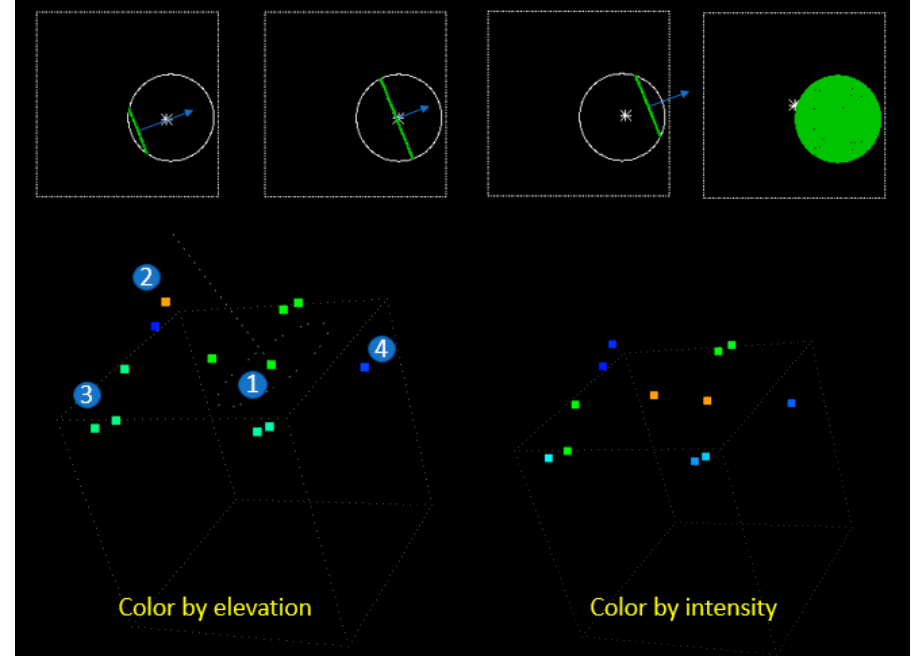
Figure 6. A cube target interacts with an incoming laser pulse at different locations. The 3D point cloud on the right side is colored by the intensity, which represents the relative energy given by the waveform integral in Figure 7. The color scheme follows the typical “rainbow” color table of the lidar point cloud visualization so that the yellowish color represents higher values and the bluish color represents lower values.